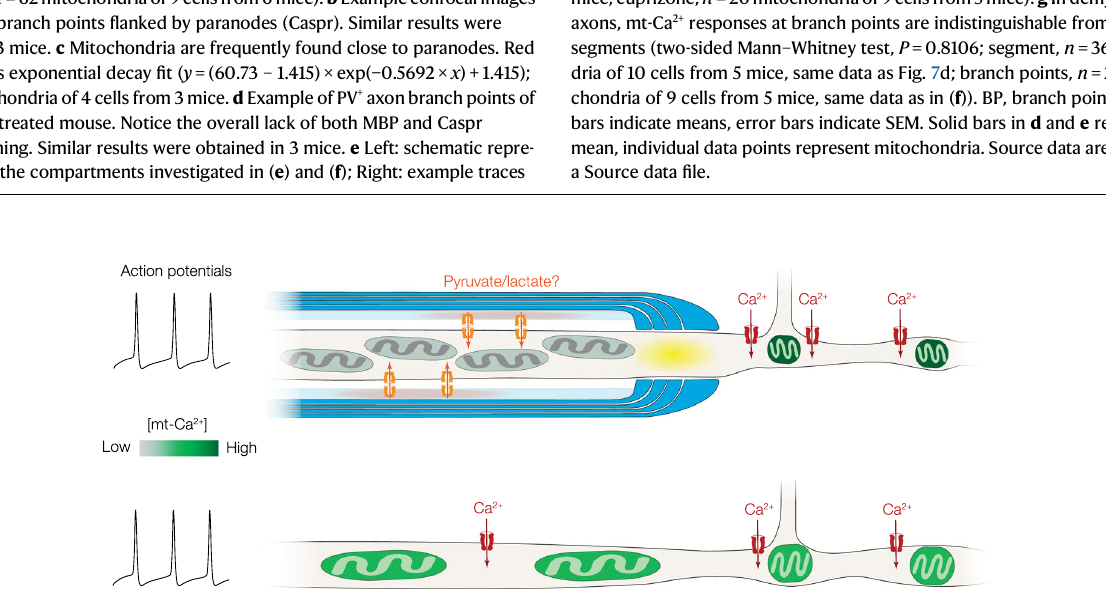
activity-dependent mt-Ca 2+ transients (grey). In branch points and unmyelinated segments, mitochondria are smaller but AP-evoked mt-Ca 2+ transients are large (dark green). Following myelin loss (bottom), mitochondria become larger and distributeuniformlyalongproximalaxons.Themt-Ca 2+ responsesareuniformand low in amplitude (light green) and nodes of Ranvier are